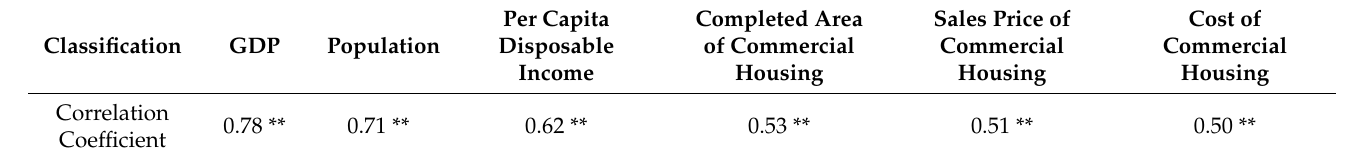
Table 6. The correlation between mean efficiency and various factors.